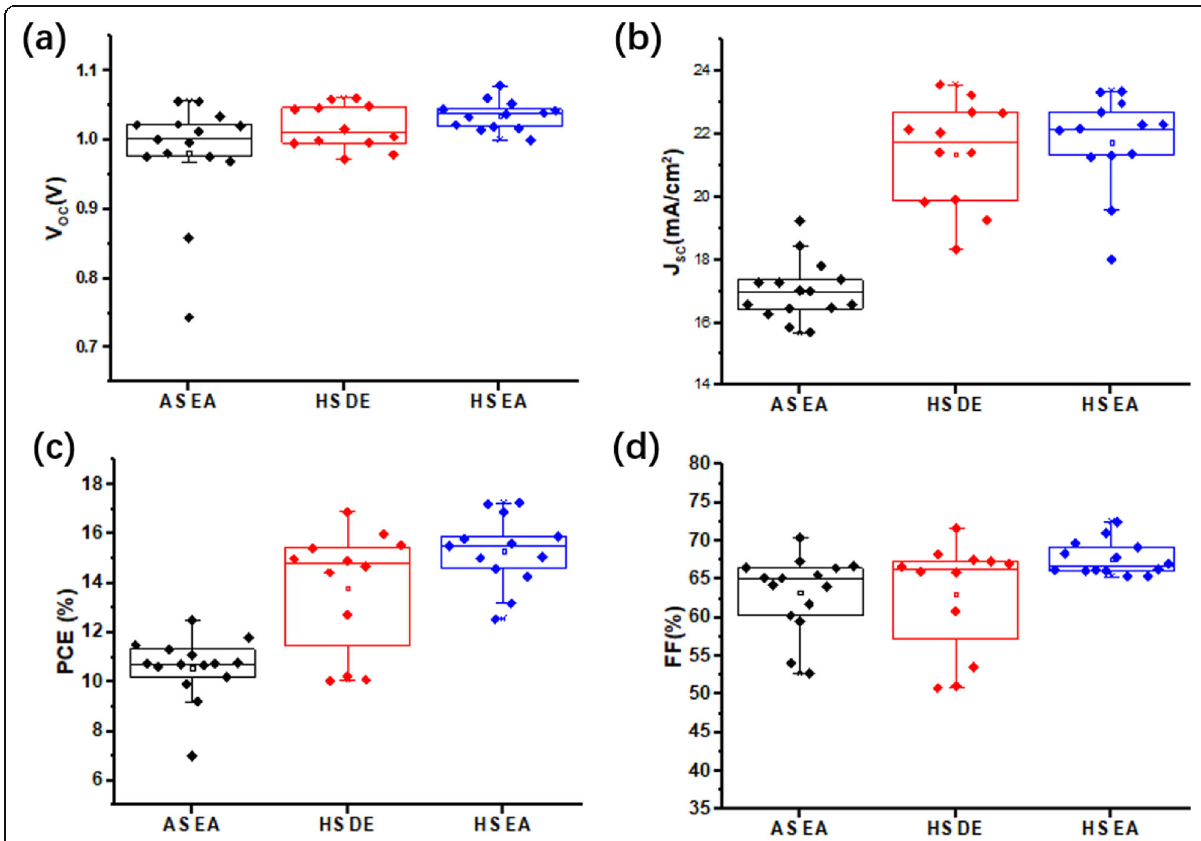
Fig. 3 Statistic data of photovoltaic parameters including V OC ( a ), J SC ( b ), FF ( c ), and PCE ( d )